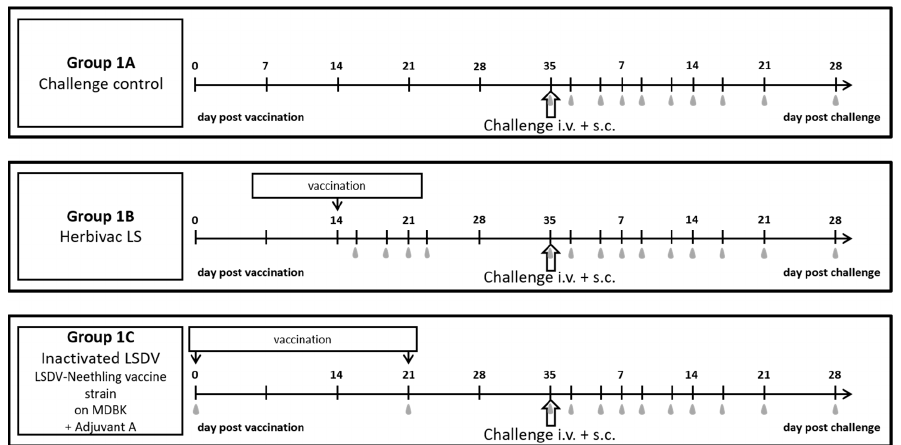
Figure 1. Experimental design of the performed proof-of-concept study. Cattle of Group 1A were not vaccinated. Cattle of Group 1B received the commercially available Herbivac LS live-attenuated vaccine at Day 14 of the animal trial. Cattle of Group 1C were vaccinated twice (Day 0 and Day 21 of the animal trial) with inactivated LSDV-“Neethling vaccine“ strain (titer before inactivation 10 7.4 CCID 50 /mL) propagated on MDBK cells and using Adjuvant A. Challenge virus was inoculated i.v. and s.c. at Day 35 of the animal trial. Grey marks display sampling days.